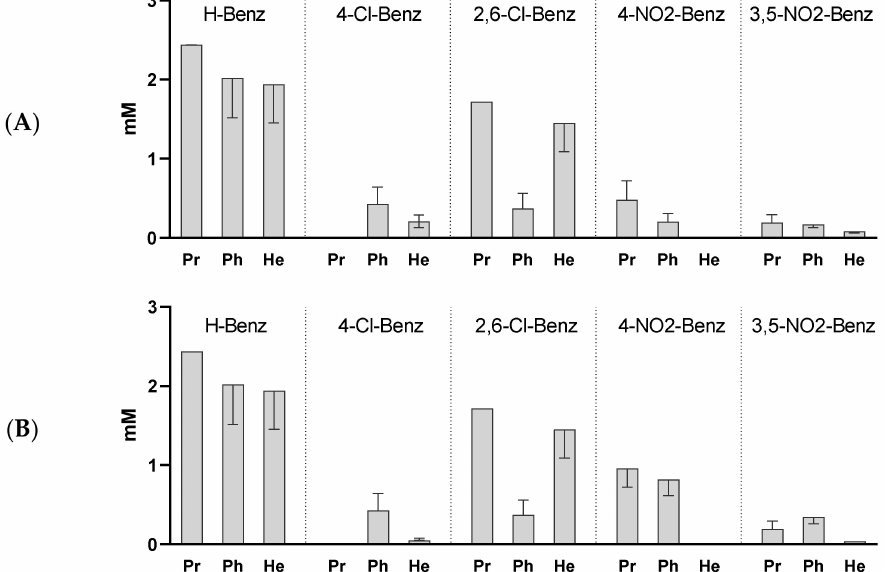
Figure 3. MIC esters under study against M. bovis BCG ( A ) and M. smegmatis ( B ). Propyl 4-chlorobenzoate was not tested. Data represent the median of 3 independent experiments and the error bars depict the interquartile range.